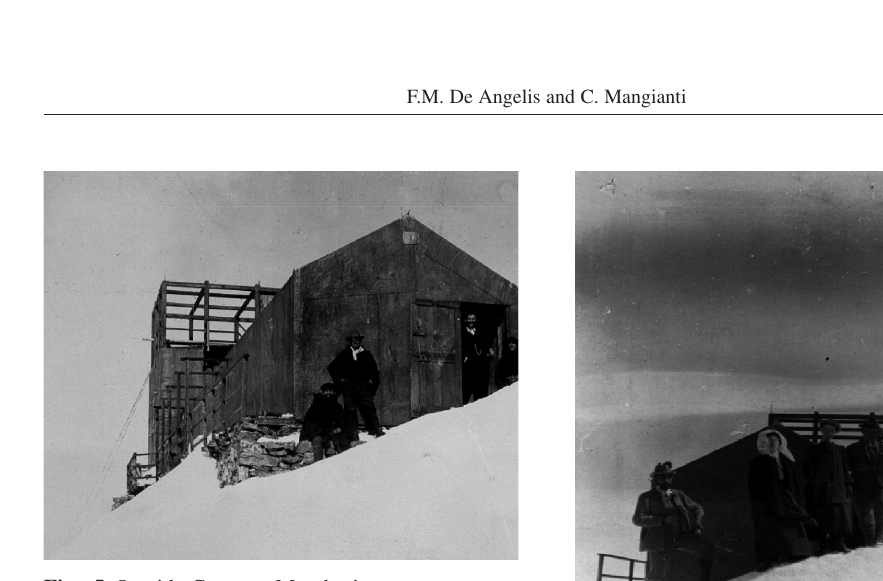
Fig. 5. Outside Capanna Margherita.